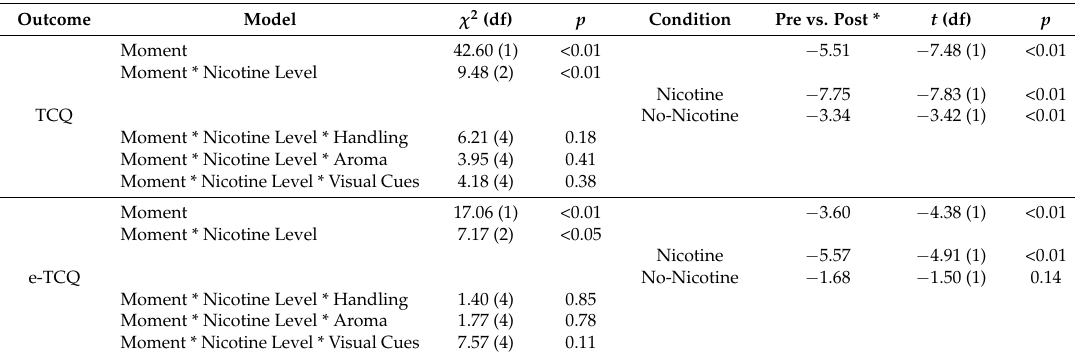
* Pre vs. Post means that Pre measurement was subtracted from Post measurements. Negative values indicate a higher Pre measurement in comparison to the post measurement.